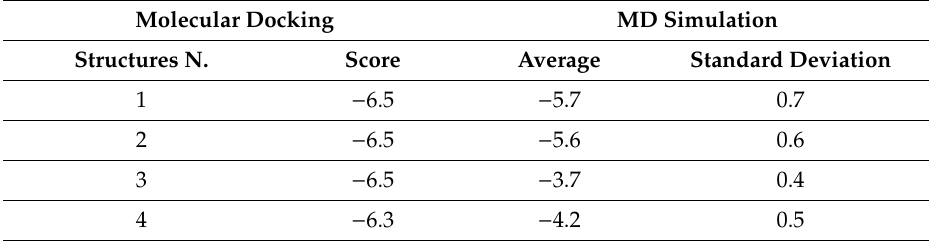
Figure 8B. A blind search performed in a volume including the whole protein surface converged towards an interaction of the PLMI motif in the extracellular domain of the GPER and more particularly within the same cavity as other ligands, including PBX1 (Figure 8A). Predicted binding score values were found to be ~ –6.5 kcal/mol (Table 1). The best structures fit with an alignment “head ‐ first”, where the N ‐ and C ‐ termini point towards the protein core and the solvent ‐ exposed region, respectively. Accordingly, the proline and the leucine at the position 2 are deeply inserted in the protein with the two hydrophobic residues able to alternate positions (Figures 8B,C). Table 1. Bindingenergies(inkcal / mol)ofthePLMImotifobtainedbymoleculardockingandMDsimulation. Molecular Docking MD Simulation Structures